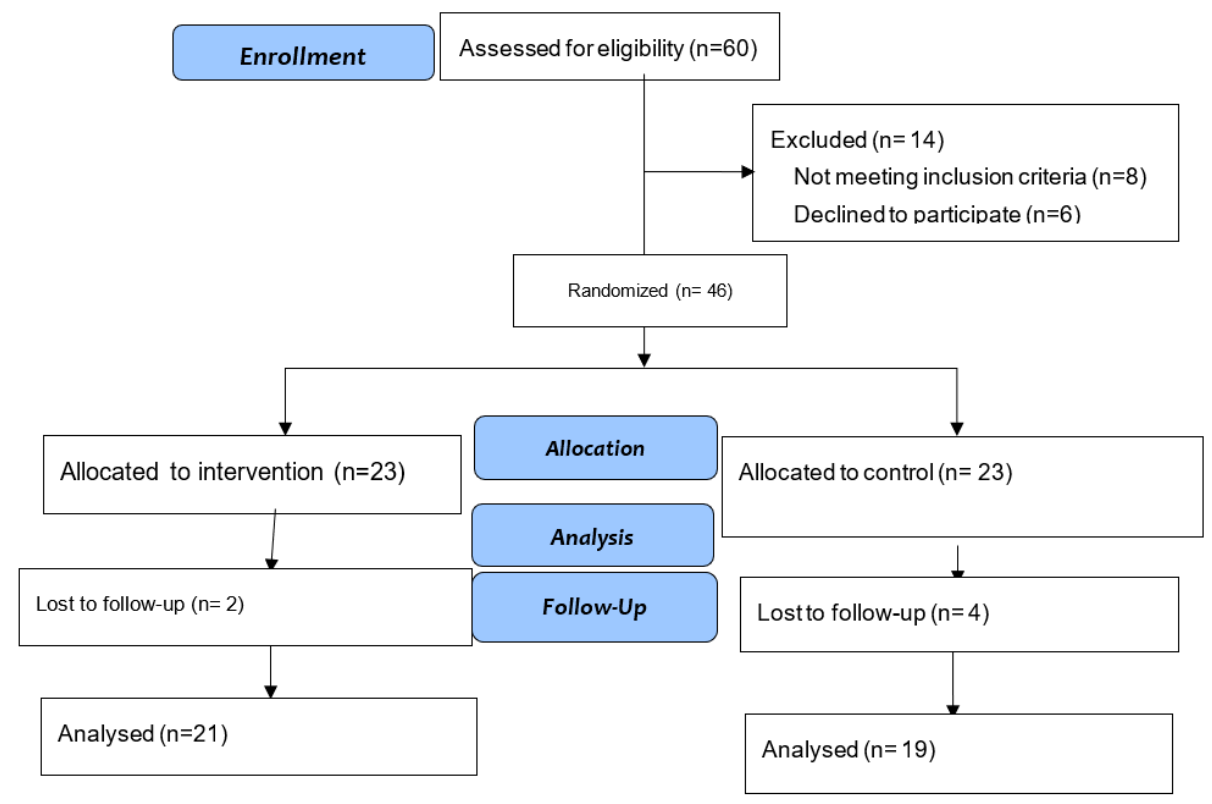
Figure 1. Diagram of the study design.